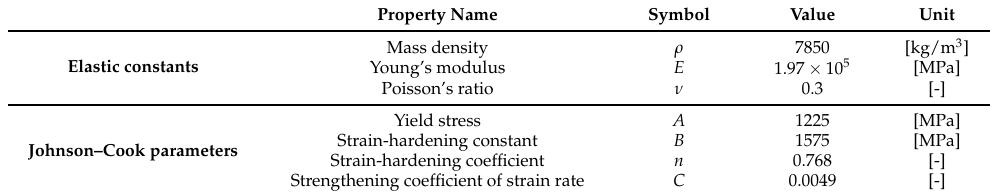
Table 4. Density, elastic constants, and Johnson–Cook parameters for the RHA steel sphere